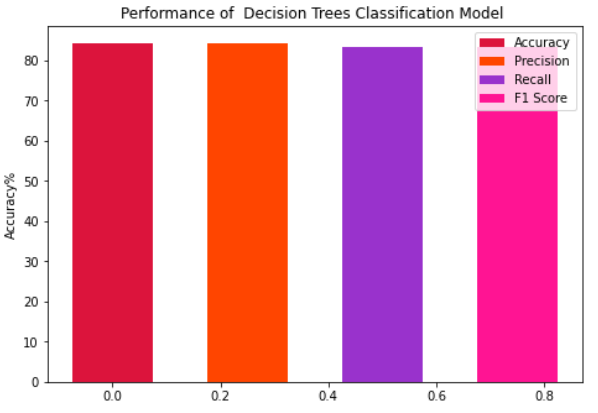
Figure 12. Performance of Bagging